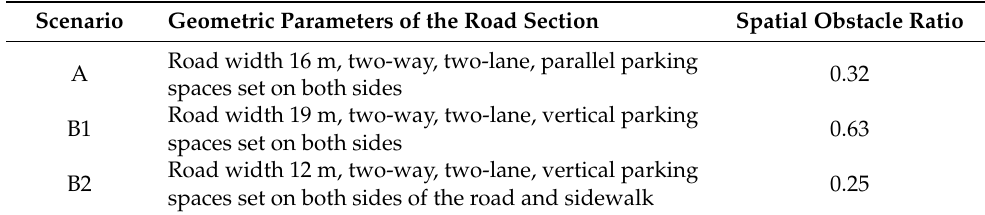
Figure 4. Geometric parameters of road sections in each scenario. Table 4. Spatial obstacle ratio of typical roadside parking scenarios.